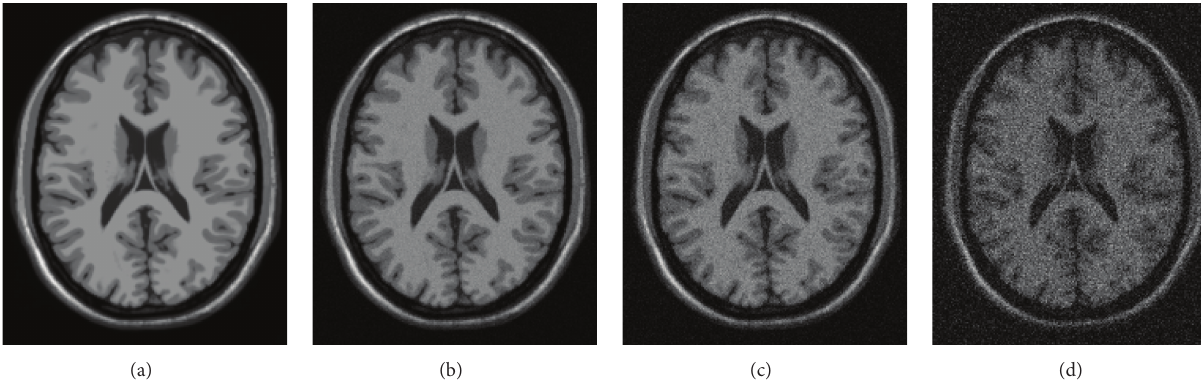
Figure 2: Noise in brain MR images. (a) Original brain MR image. The images corrupted by 3%, 7%, and 11% noise in (b), (c), and (d),